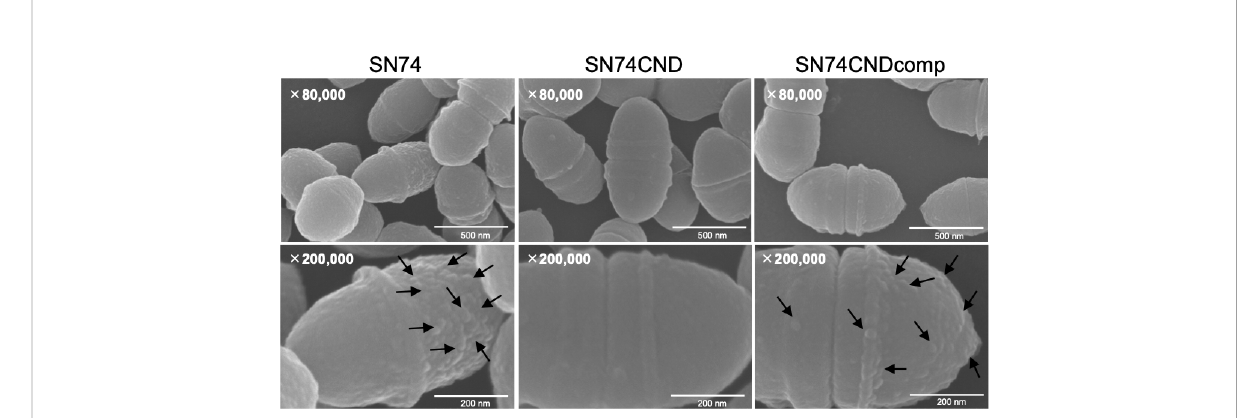
FIGURE 3 Scanning electron microscopic images of S. mutans strains SN74, SN74CND, and SN74CNDcomp. Scale bar of the upper image, 500 nm; scale bar of the lower image, 200 nm; magni fi cation of the upper image, ×80,000; magni fi cation of the lower image, ×200,000. The arrows indicate the bumpy